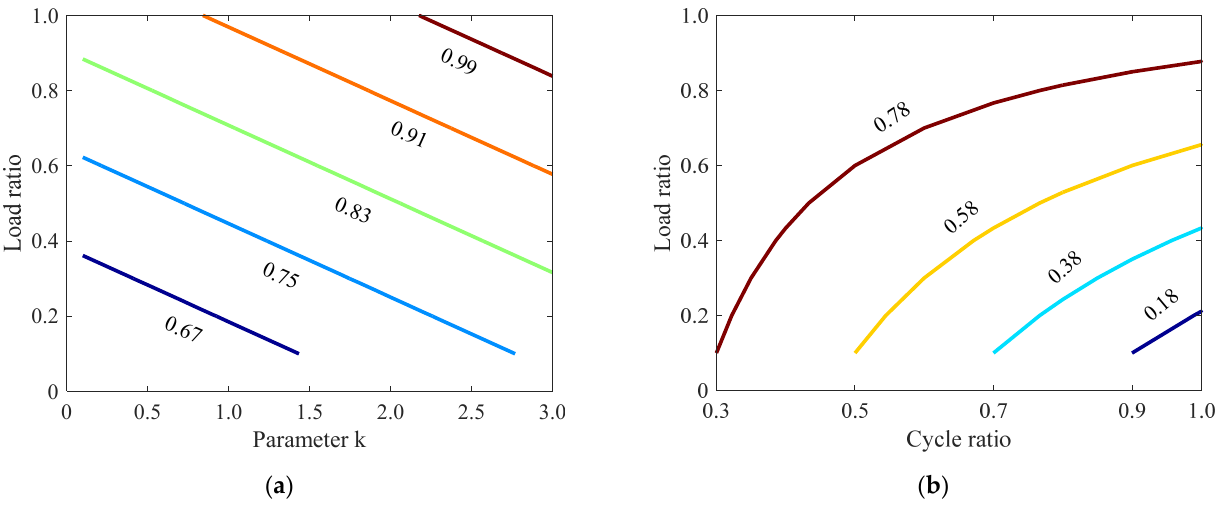
Figure 3. Contours of physics-based Model I. ( a ) Cycle ratio = 0.3. ( b ) Parameter k = 1.5. When the cycle ratio is 0.3, the contours of Model I concerning the loading ratio and variable k are shown in Figure 3a. It can be observed that the loading ratio and k both have significant influences on the strength degradation of stud connectors. Figure 3b shows the strength degradation distribution versus the loading ratio and cycle ratio with k equaling 1.5. It is shown that the shear strength of stud connectors will vastly decrease as the cycle ratio increases.